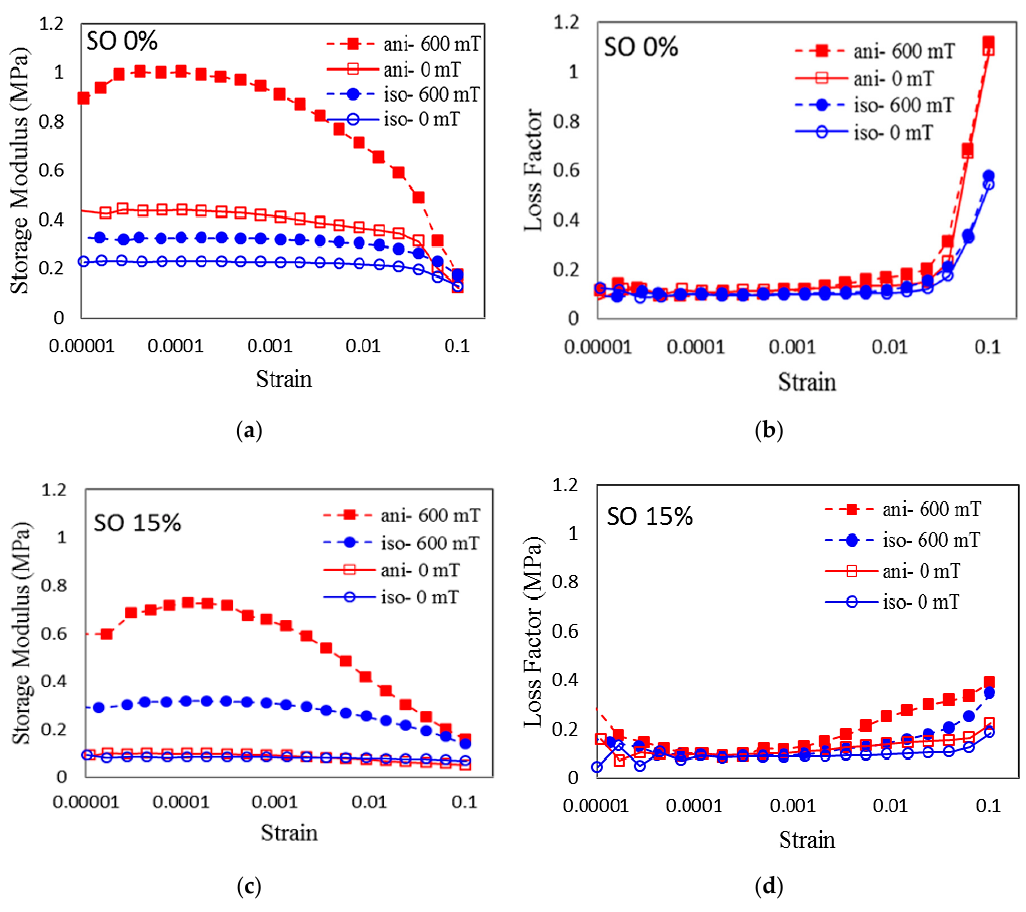
Figure 6. Storage modulus and loss factor of MRE with ( a , b ) 0 wt% of SO and ( c , d ) 15 wt% of SO as a function of oscillation strain at various magnetic fields.